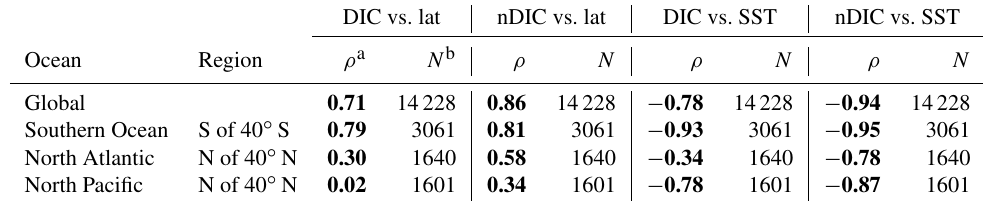
Table 3. Global and regional correlations between DIC and nDIC and SST and